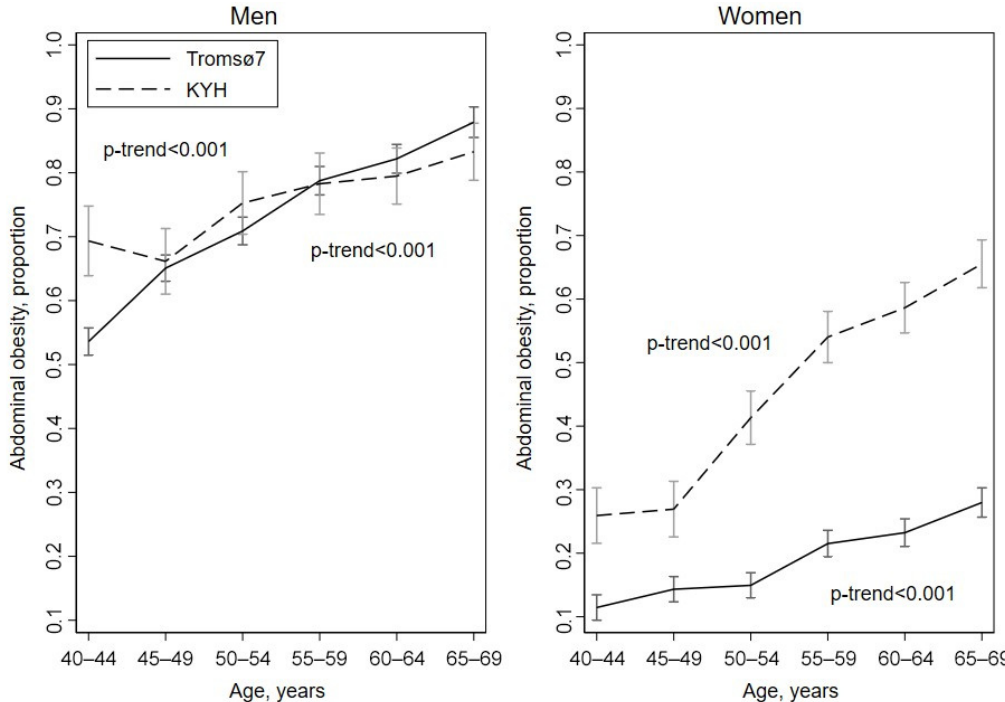
Figure 3. Prevalence of abdominal obesity (WHR > 0.9 for men and >0.85 for women) with 95% confidence intervals by study, sex and age.